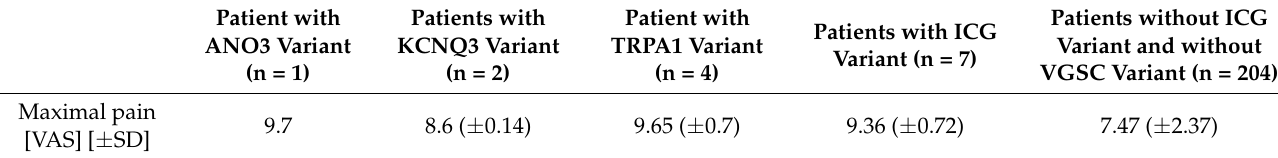
Table 3. Mean pain scores in patients with small fiber